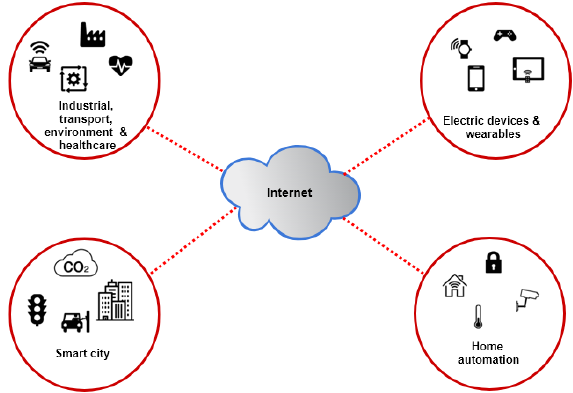
Figure 1. Data intensive IoT